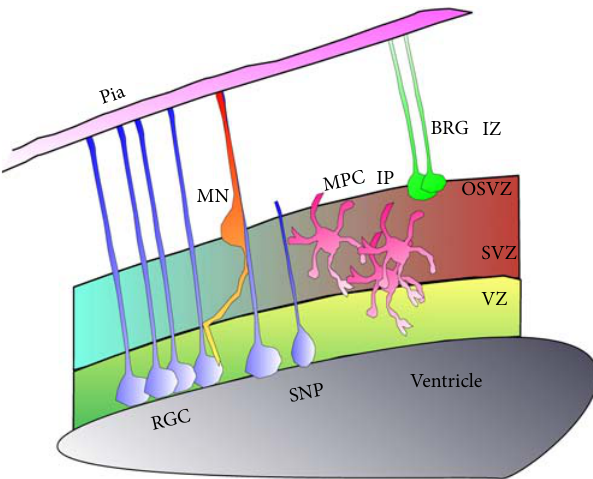
Figure 1: Schematic presentation of progenitors in the developing cerebral cortex. Radial glia cells (RGCs) extend their processes from theventricularzone(VZ)tothepialsurface.Thesecellsproliferatein asymmetricalfashiontoproduceadditionalRGCorasymmetrically to produce a progenitor and a multipolar cell (MPC), which may be either a postmitotic neuron or an intermediate progenitor (IP), which can further divide in the subventricular zone. The VZ con- tains additional short neuronal progenitors (SNP). In the SVZ and the outer SVZ (OSVZ), an additional type of progenitors was des- cribed, basal radial glia (BRG), which lack the connection to the ventricle. A bipolar migrating neuron (MN) is moving towards the intermediate zone